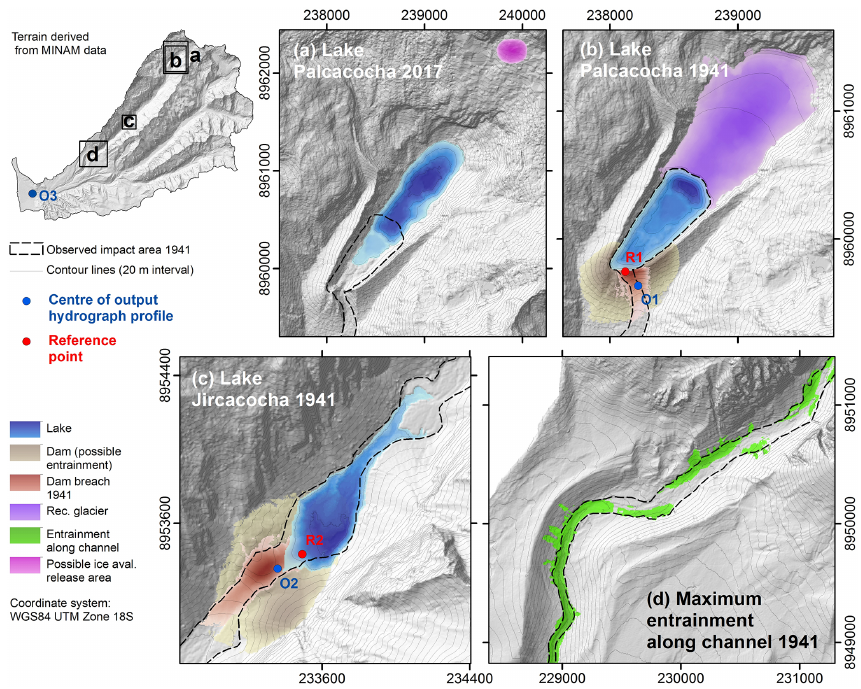
Figure 4. Reconstruction of lakes and topography. (a) Lake Palcacocha in 2017. (b) Lake Palcacocha before the 1941 event. (c) Lake Jircacocha before the 1941 event. (d) Part of the promontory section of the Cojup Valley, with lowering of the valley bottom by up to 50m. The possible rock avalanche release area is shown in (a) for clarity but is applied to the 1941 situation. Table 2. Reference information used for back-calculation of the 1941 process